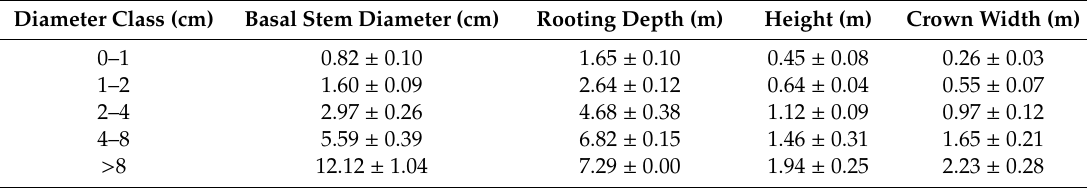
Table 1. Basic information of the measured trees for each diameter class. Data are mean ± 1